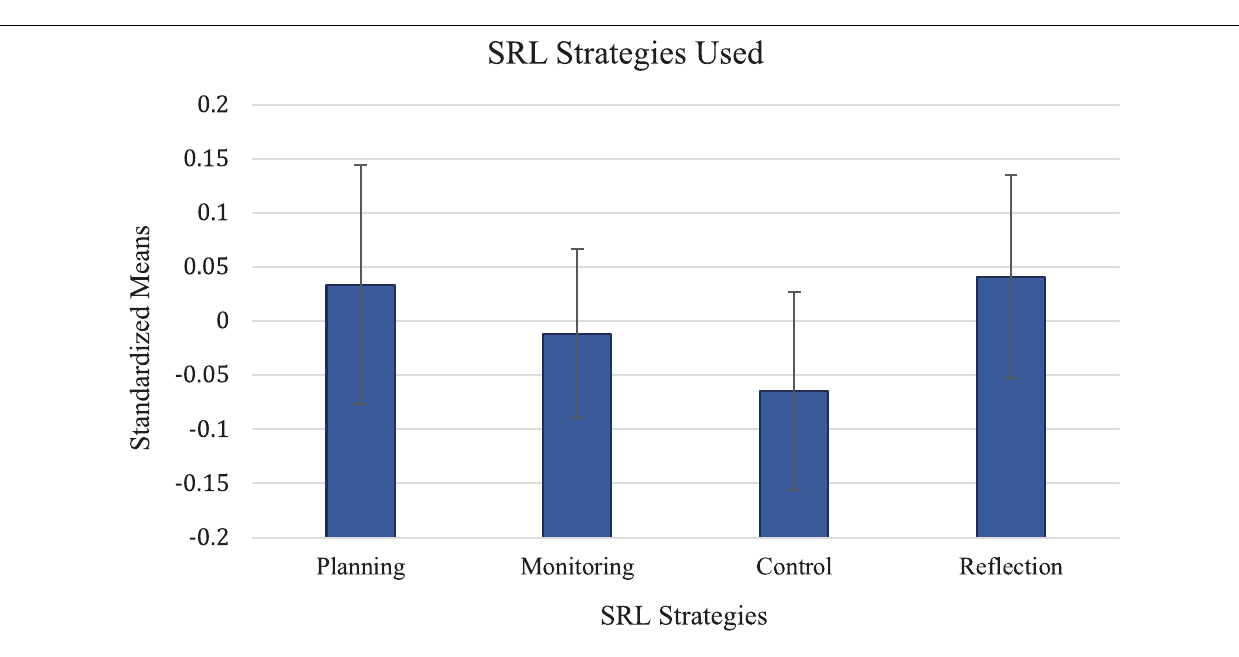
FIGURE 1 | Standardized means of individual SRL strategies used.